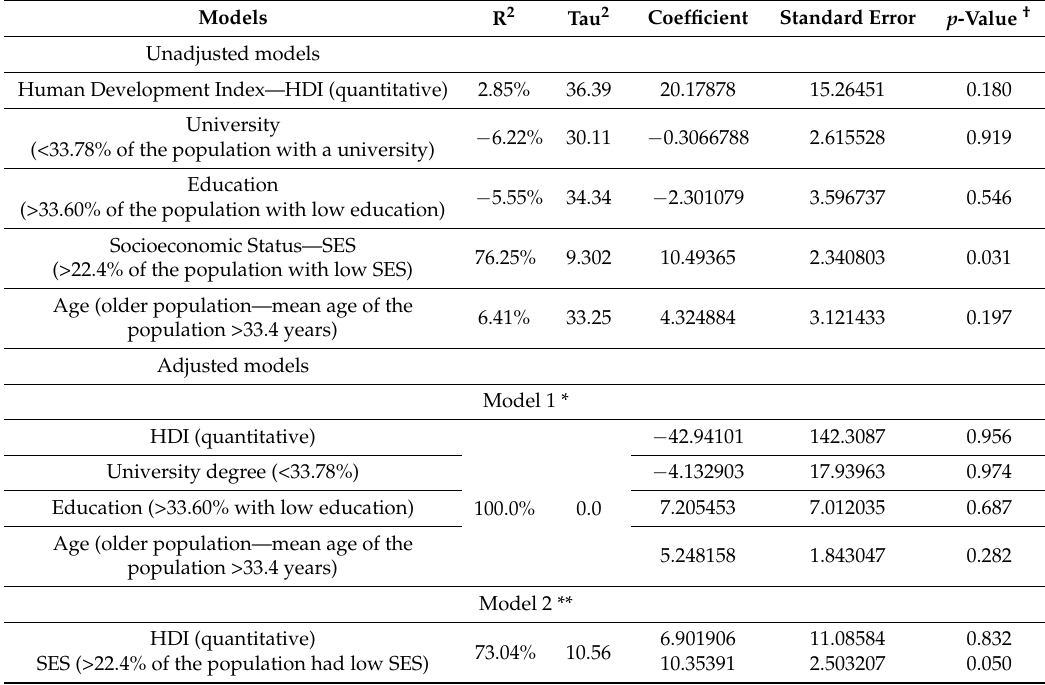
Table 1. Meta-regression for decayed, missing, and filled teeth and